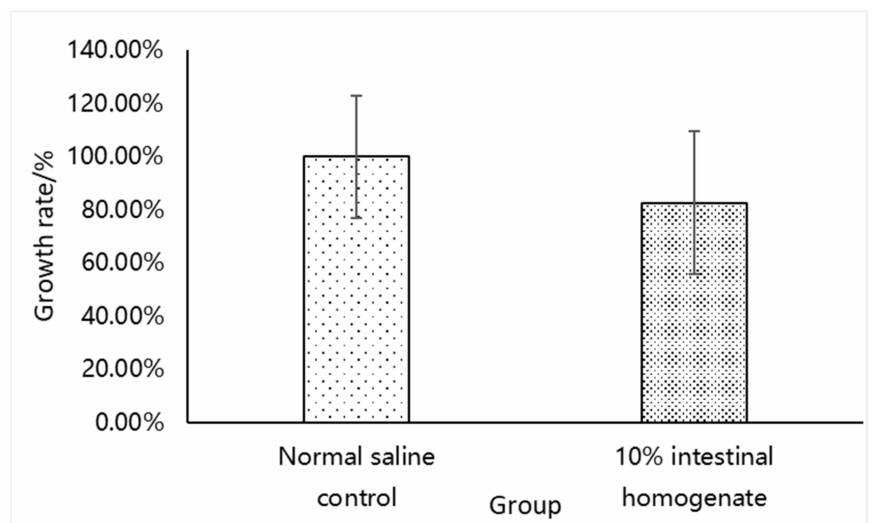
Figure 2. Comparison between the growth rate of Gs in the normal saline control and 10% GI tract homogenate ( n = 9) on the NA plate.